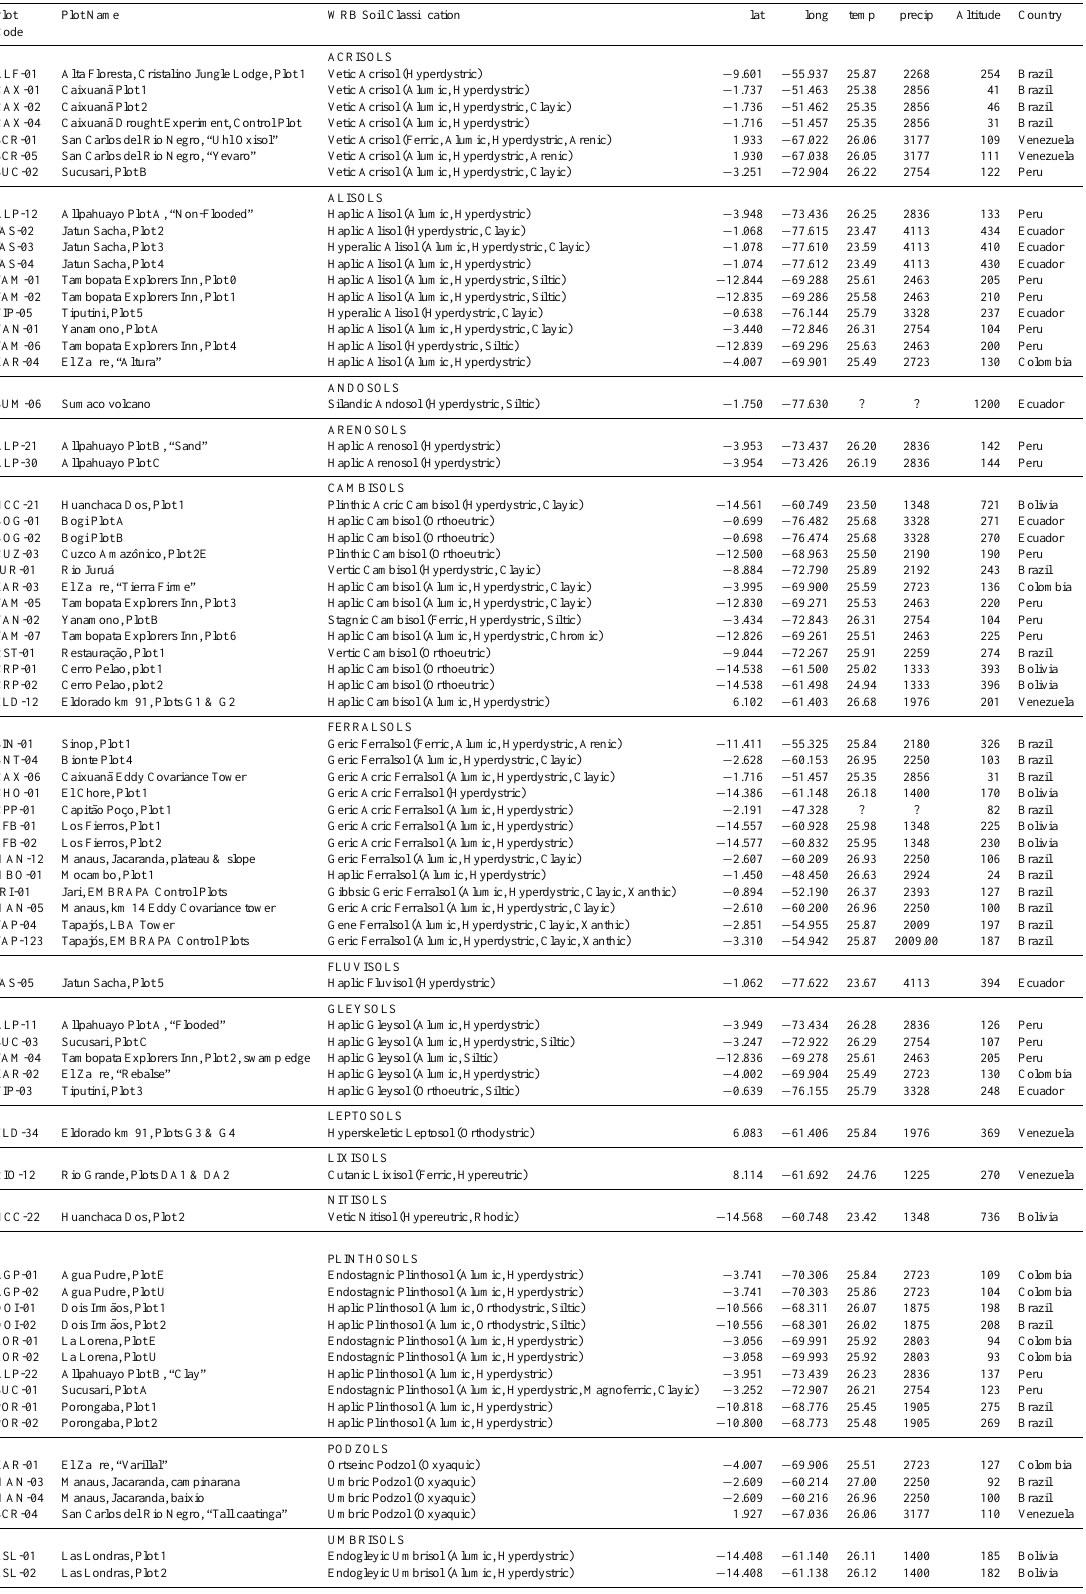
Table 1. Study sites, their names, codes and World Reference Base soil classification. Geographic locations and climatic information are also